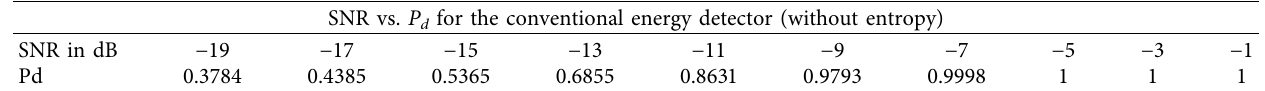
Table 2: Simulation result of SNR vs. P